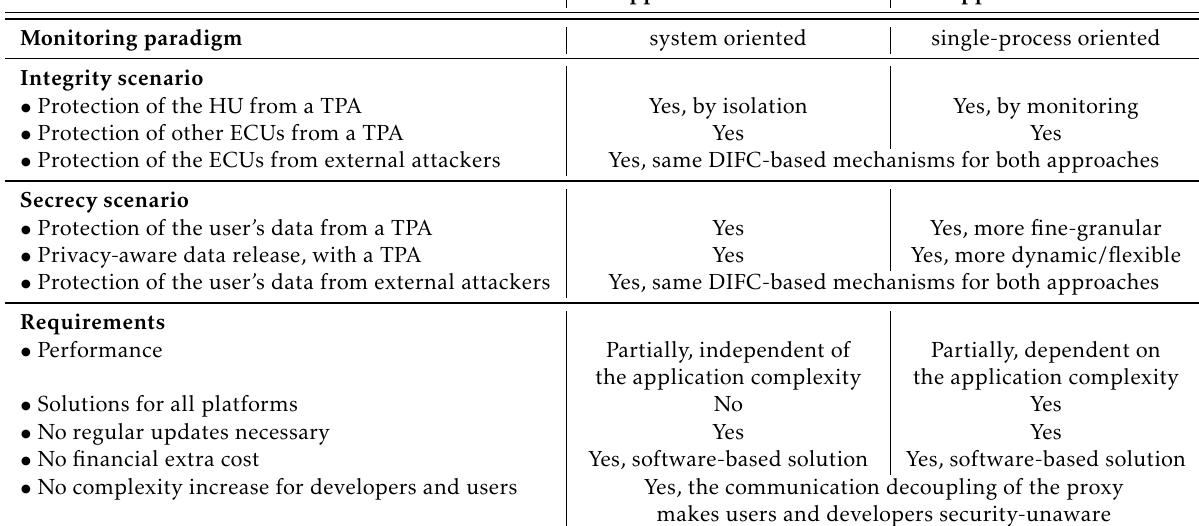
Table 3. Summary of our system evaluation with respect to the attack scenarios of Section 2.2 and the requirements of Section 2.3 (More details are provided in Section